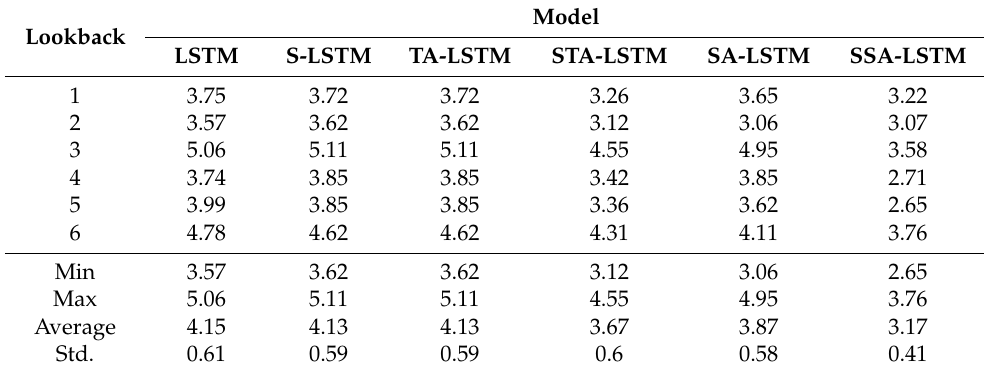
Table 2. Performance of different LSTM models for dengue prediction in Malaysia.